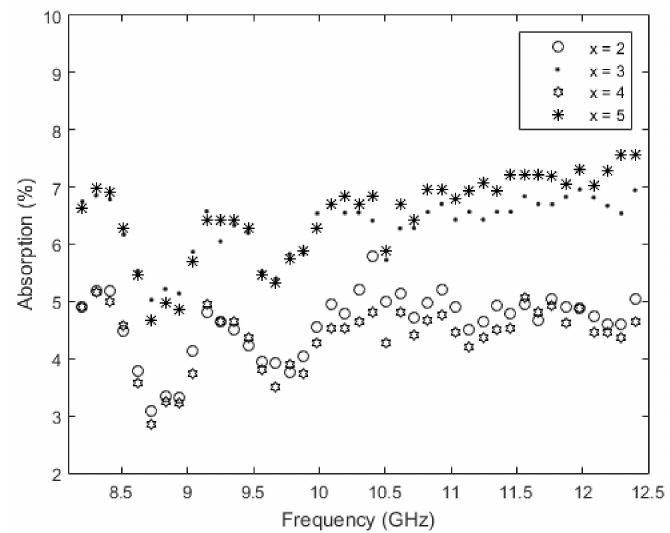
Figure 9. Frequency dependencies of absorption for S r0.3 Ba 0.4 Pb 0.3 Fe 12 O 19 /(CuFe 2 O 4 ) x composite samples (x = 2, 3, 4 and 5).